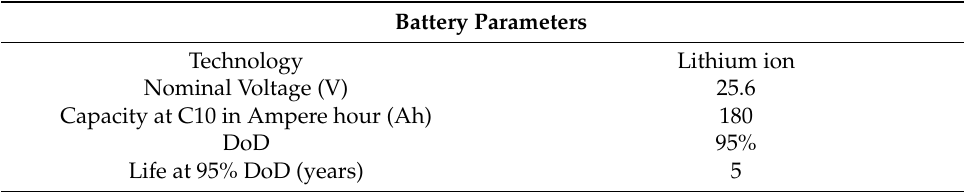
Figure 6. Efficiency curve for the selected polycrystalline module. Table 4. Specifications of the battery considered for the analysis [source- PVsyst 7.2